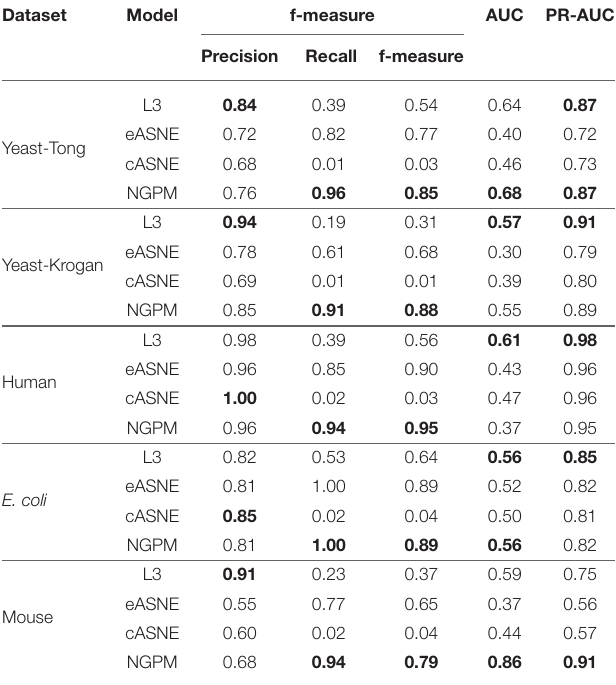
TABLE 2 | The performance of models.